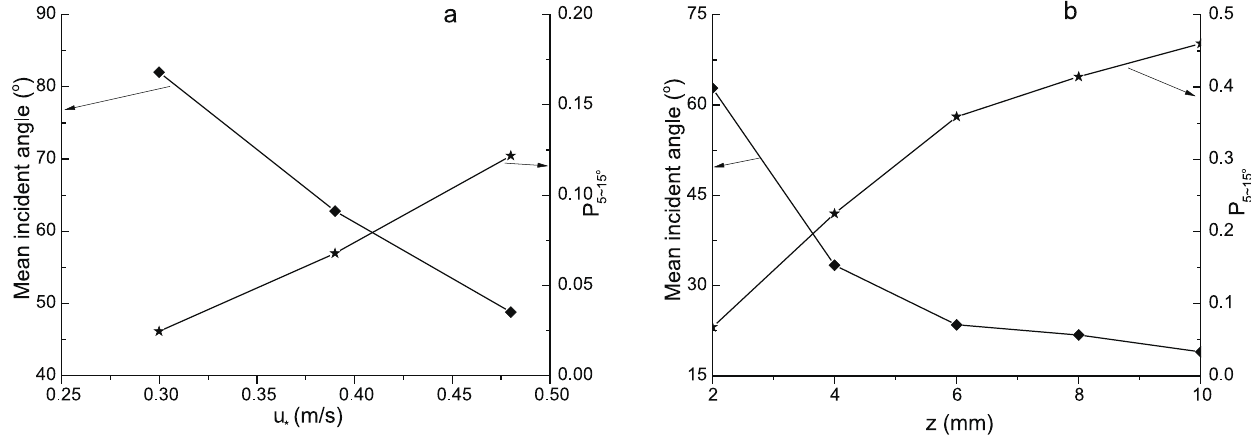
Figure 5. The mean incident angle and the proportion of 5 6 –15 6 incident angles ( P 5 { 15 0 ) in different wind strengths (a) and measuring height (b). The diamond and the star symbols represent the mean incident angle and P 5 { 15 0 ,